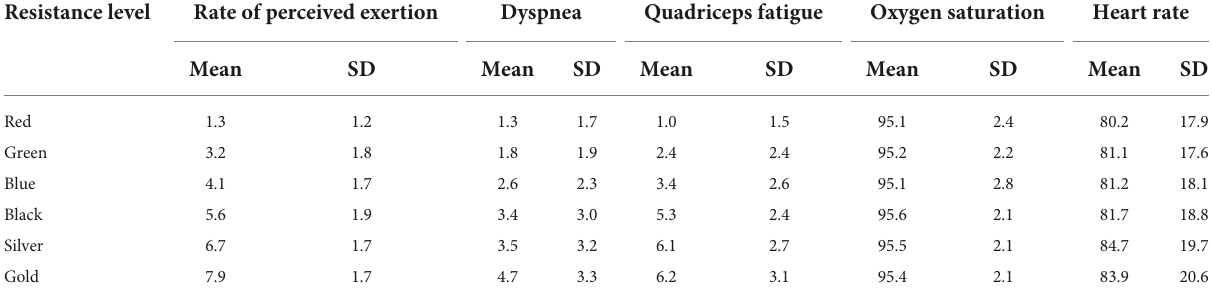
TABLE 2 Acute symptoms during the different resistance